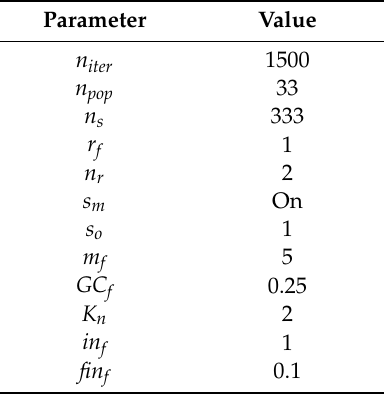
Table 2. The GA model’s parameters.